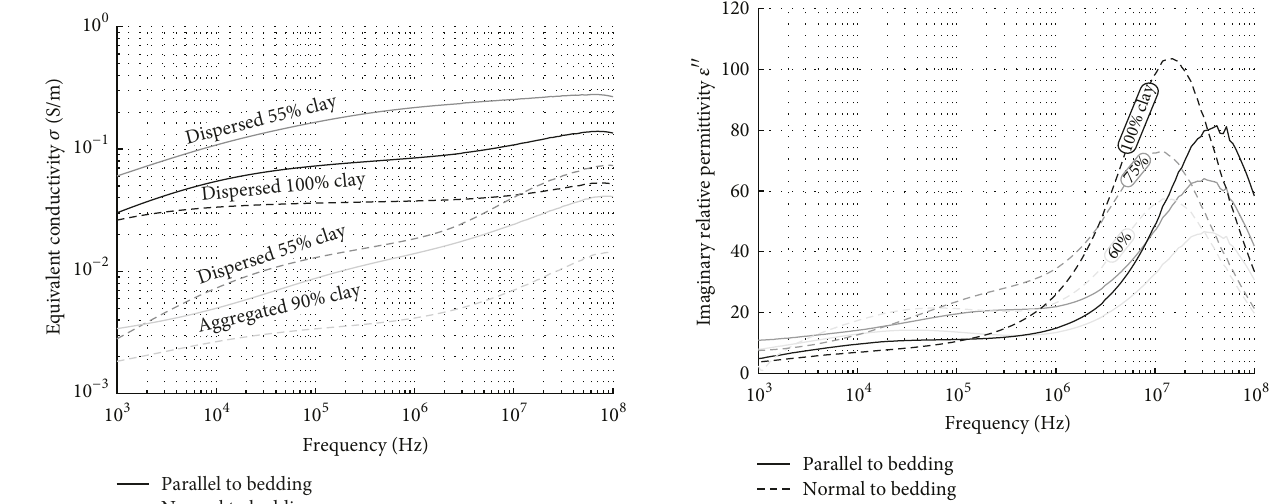
Figure 12: Frequency dependent dielectric loss in artificial shales with varying clay